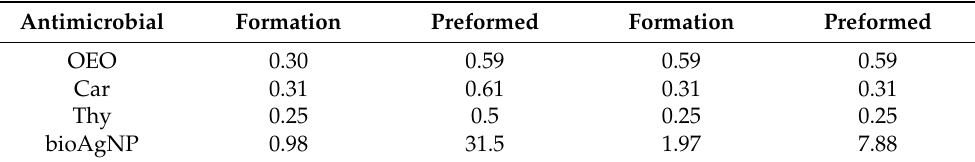
Table 1. Sessile minimal inhibitory concentration (SMIC ≥ 95 ) of oregano derivatives (mg/mL) and biological silver nanoparticles (bioAgNP, µ g/mL) individually against enteroaggregative Escherichia coli (EAEC 042) and KPC-producing Klebsiella pneumoniae (KPC), at both early stage of biofilm